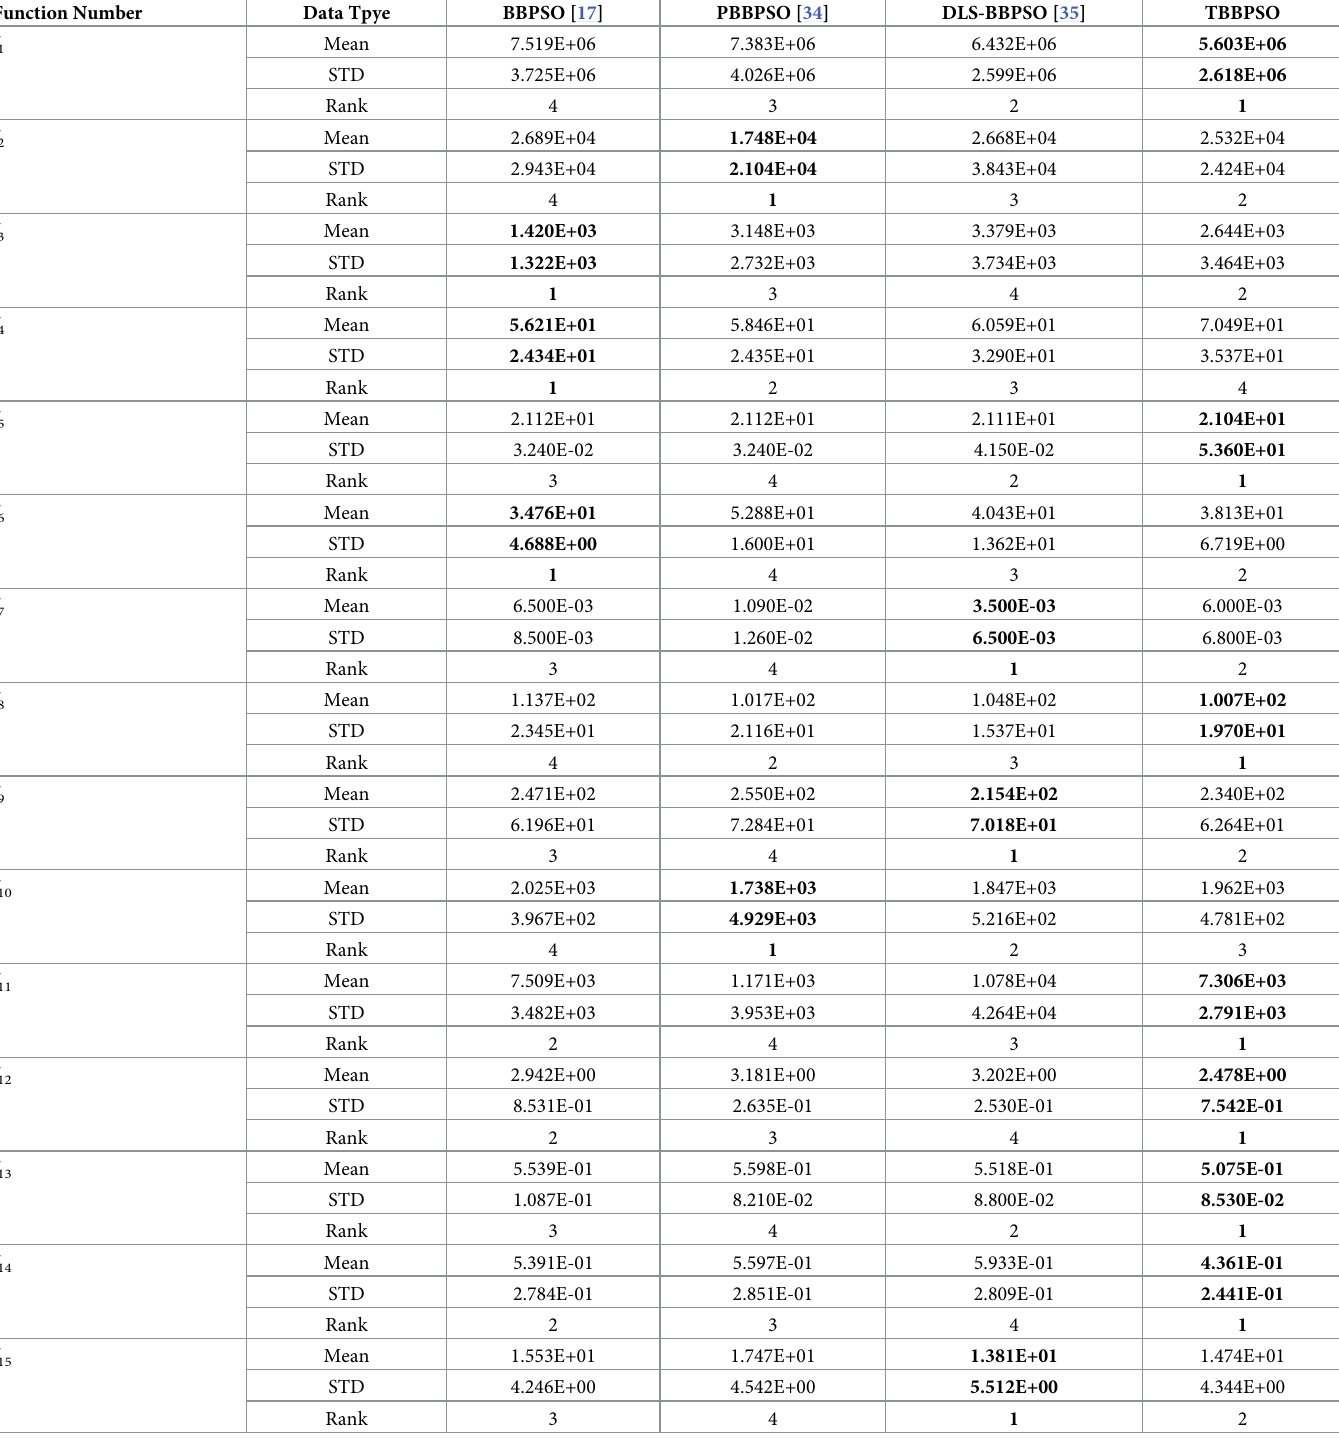
Table 3. Experimental Results, ME of BBPSO, PBBPSO, DLS-BBPSO and TBBPSO for f 1 – f 15 . Mean is the mean value from 31 independent runs, STD is the standard deviation of the 31 runs, Rank is the rank of 4 algorithms. Function